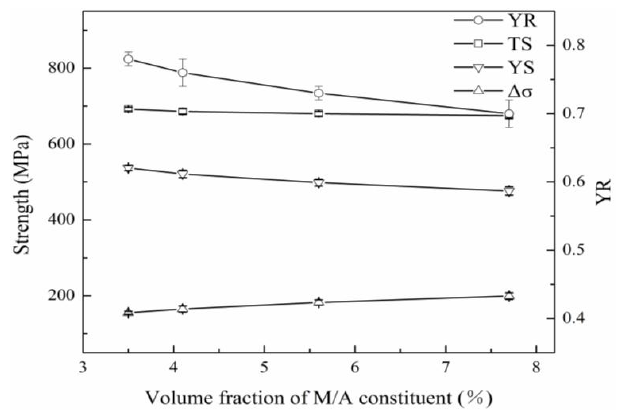
Figure 12. TS , YS , ∆ σ and YR of experimental steels varied with the area fraction of M/A constituent, f M/A . TS —tensile strength, YS —yield strength, ∆ σ —strain hardening magnitude, YR —yield-to-tensile strength ratio and M/A—martensite/austenite.